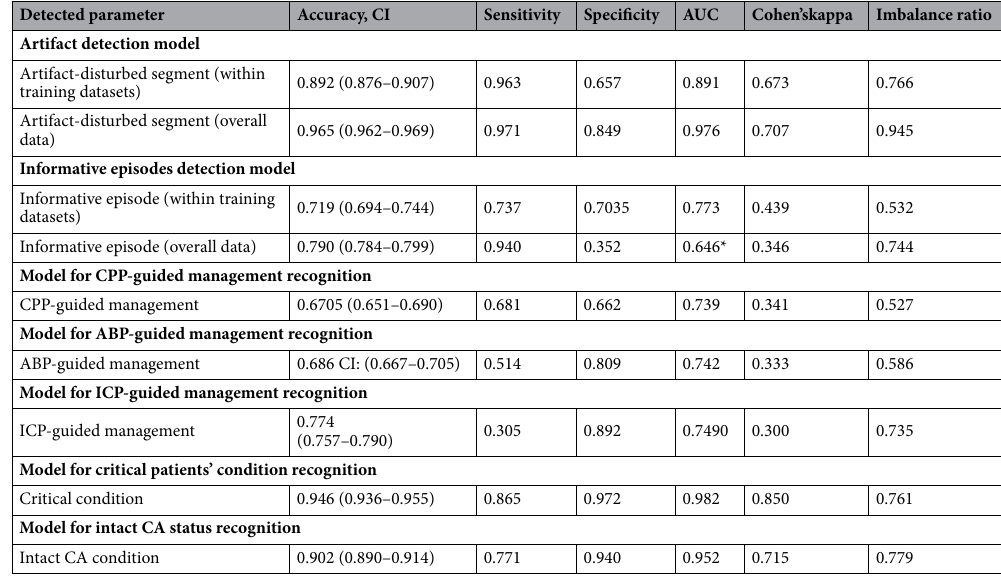
Table 2. Model accuracy, sensitivity, specificity to predict “artifact-disturbed” segments, and “informative” episodes and to recognize cases of CPP-, ABP- or ICP-guided management for personalized TBI treatment. Here, CA is the cerebrovascular autoregulation, ICP is the intracranial pressure, ABP is the arterial blood pressure, CPP is the cerebral perfusion pressure, AUC is area under the curve, , and CI is confidence interval at the 95% level. Imbalance is the ratio of data samples between classes in the datasets. * AUC is calculated assuming output classes with a fixed